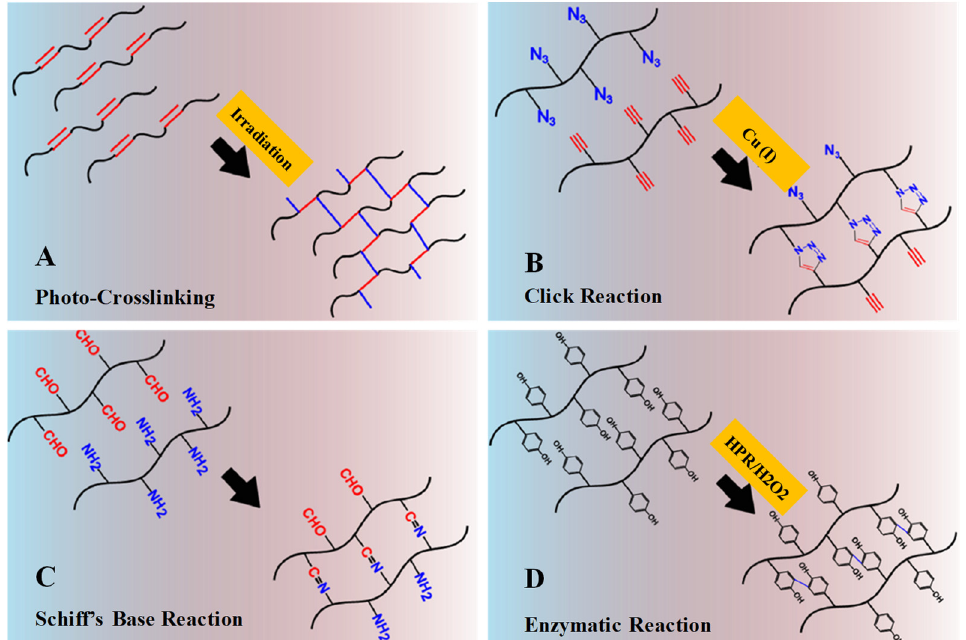
Figure 6. Schematic illustrations of chemical crosslinking mechanism: ( A ) Gelation by photo-crosslinking reaction of vinyl groups bearing polymers. ( B ) Gelation by alkyne-azide click reaction with Cu (I) as catalyst. ( C ) Gelation by Schiff’s base reaction between aldehyde and amine groups. ( D ) Gelation by enzymatic reaction with horseradish peroxidase and hydrogen peroxide as catalyst system. Adapted with permission from ref.[8]. Copyright © 2015 European Polymer Journal .